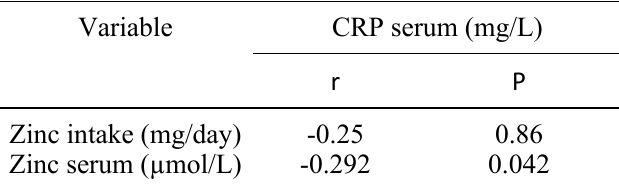
Table 3. Correlation between zinc intake with CRP levels and zinc serum levels with CRP